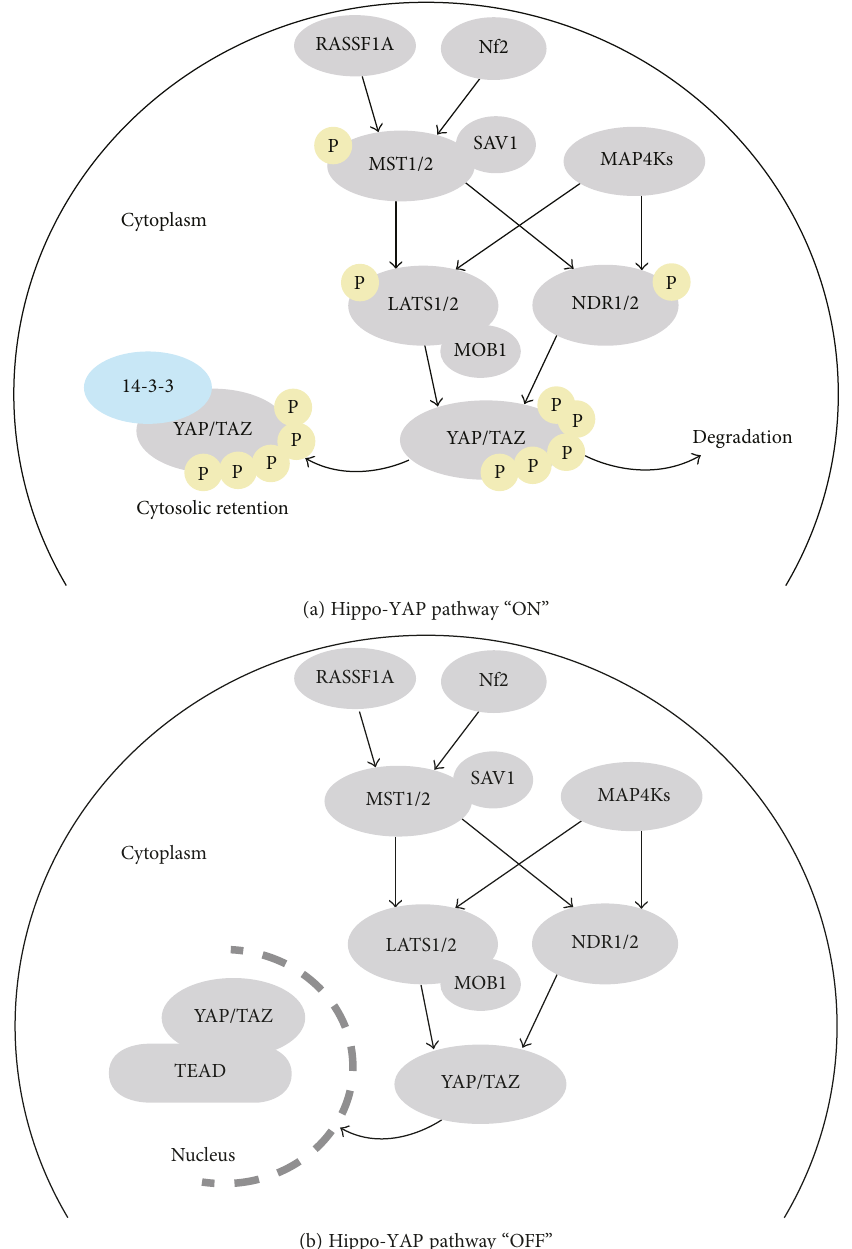
Figure 1: The overview of Hippo-Yap signaling pathway. (a) YAP and TAZ are phosphorylated and held in cytoplasm when the Hippo-YAP pathway is at the “ ON ” status. (b) Unphosphorylated YAP and TAZ accumulate in the nucleus with TEAD when the Hippo-Yap pathway is at the “ OFF ”